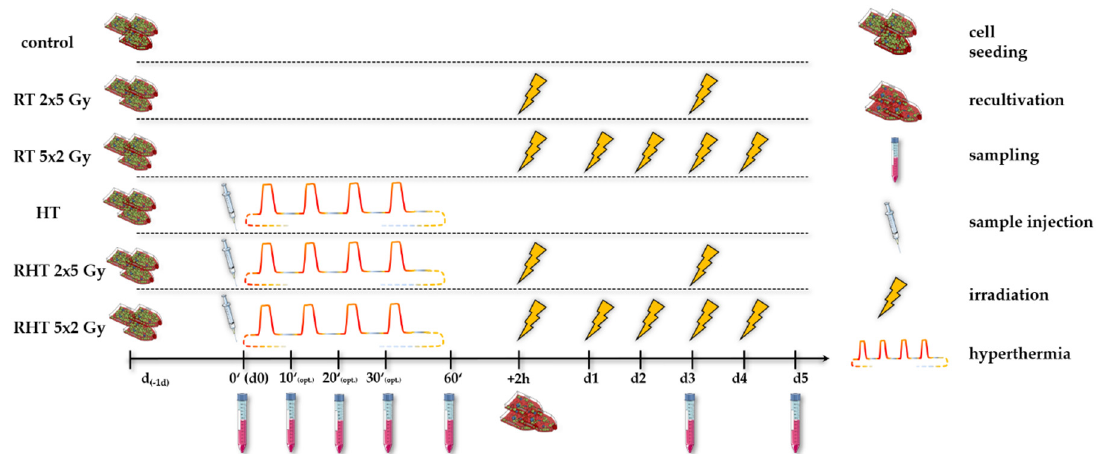
Figure 3. Experimental treatment set-up: The cells were seeded cell line-dependent one day prior to the treatment ( d -1d ) for not more than 90% of confluency during the whole treatment. Standard sampling in all arms was performed on day 0 ( d 0), d 3 (72 h) and d 5 (120 h). In the HT and combinatory arm, i.e., radiotherapy & hyperthermia (RHT), sample injection of 1x10 7 cells into the HT system was performed at time point d 0 (0 ′ ), followed by an effective heating session of at most 60 min (60 ′ ). After the HT treatment, cells were recultivated into 75 cm 2 t-flasks according to their subsequent treatment. Irradiation in the radiotherapy arm (RT) and combinatory RHT arm was performed in 75 cm 2 t-flasks with clinically relevant doses of either 2 × 5 Gy (hypo) or 5 × 2 Gy (normo) at time point +2 h. Irradiation in the respective RT and RHT arms was always performed at the same time [14].